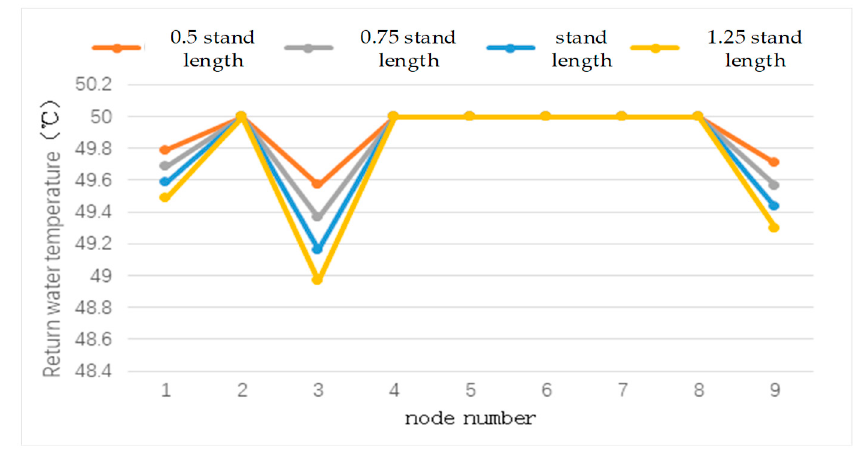
ff erent pipeline